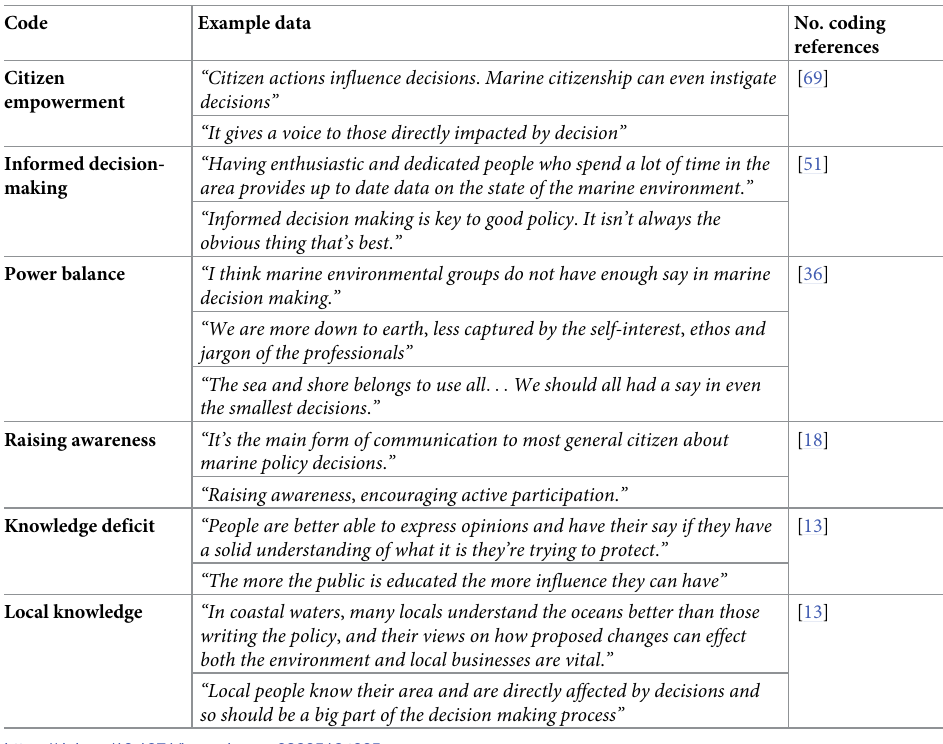
Table 5. Importance of marine citizenship in marine decision-making processes. Responses given by active marine citizens to the question “In what ways do you think marine citizenship is important for the process of marine decision- making?” Example data from sample of active marine citizens (N =